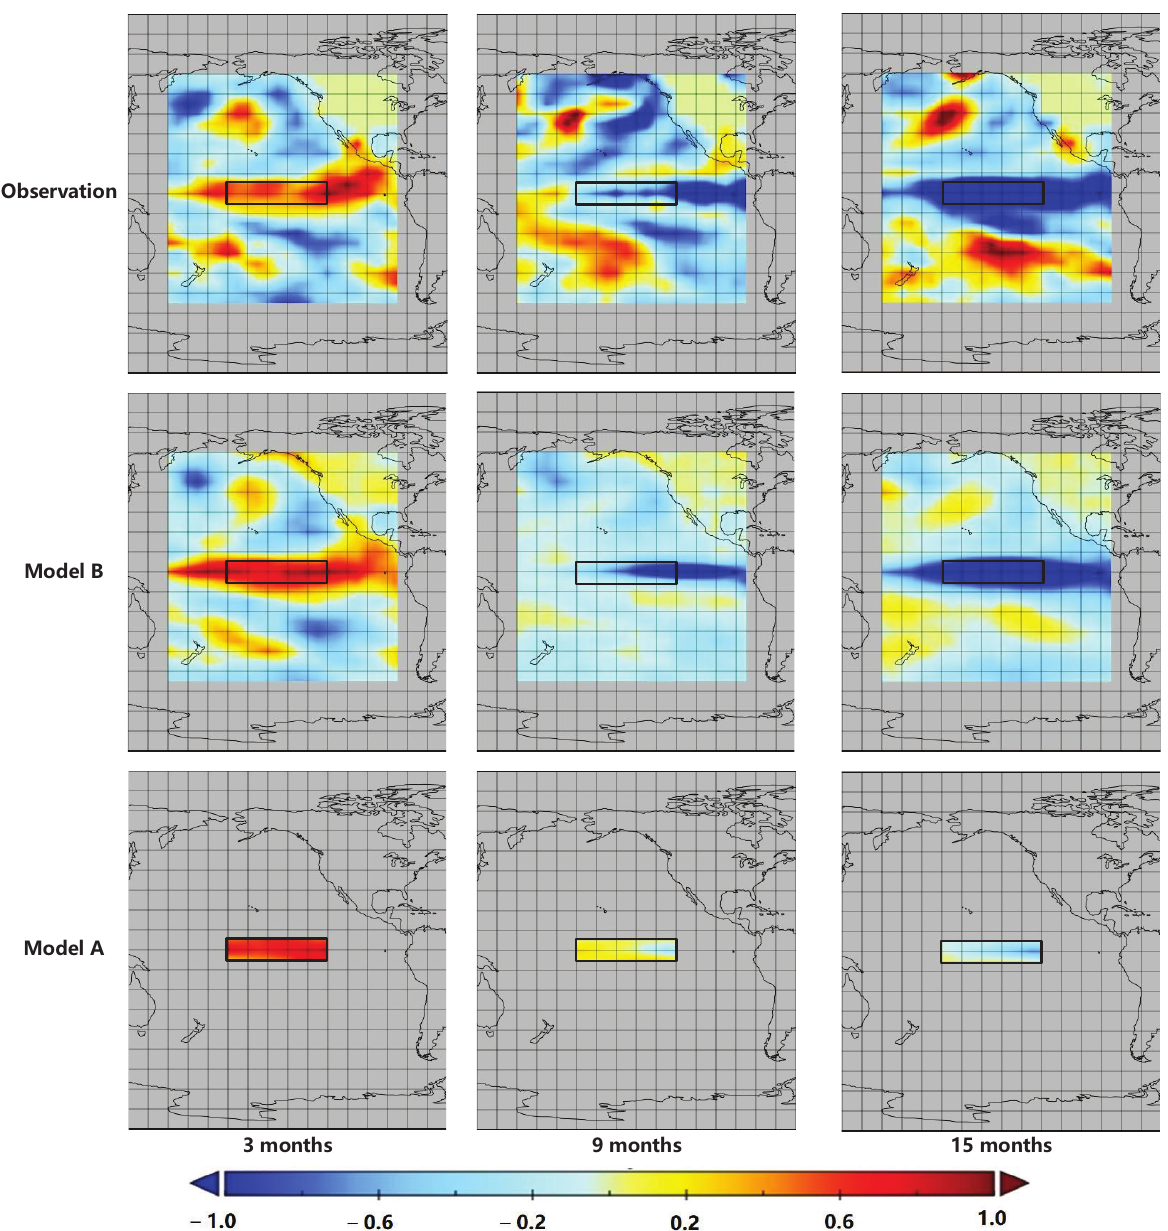
Figure 6. SSTA regional distribution map with different lead times. Observation represents the real SST, and model A (Nino3.4 area) and model B (Pacific area) represent the predicted